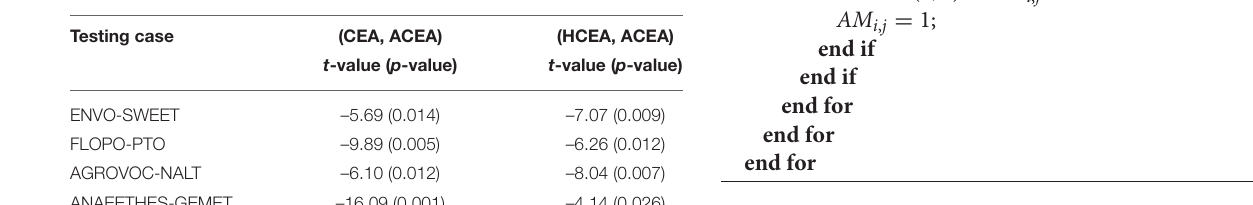
TABLE 3 | T -test on alignment’s quality.